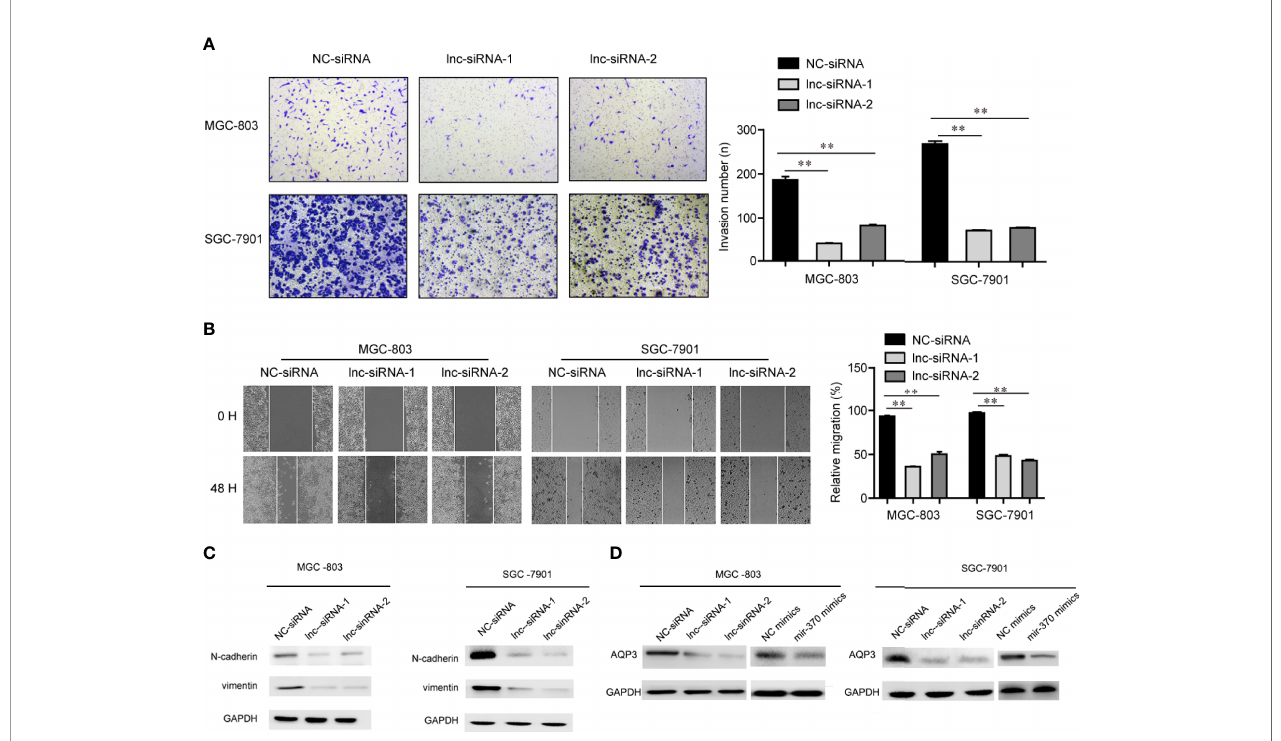
FIGURE 4 | LINC00659 contributed GC cell mobility. (A) Transwell assays detected the invasive abilities of GC cells. (B) Wound-healing assays determined the cell migration capacities of GC cells. **P <